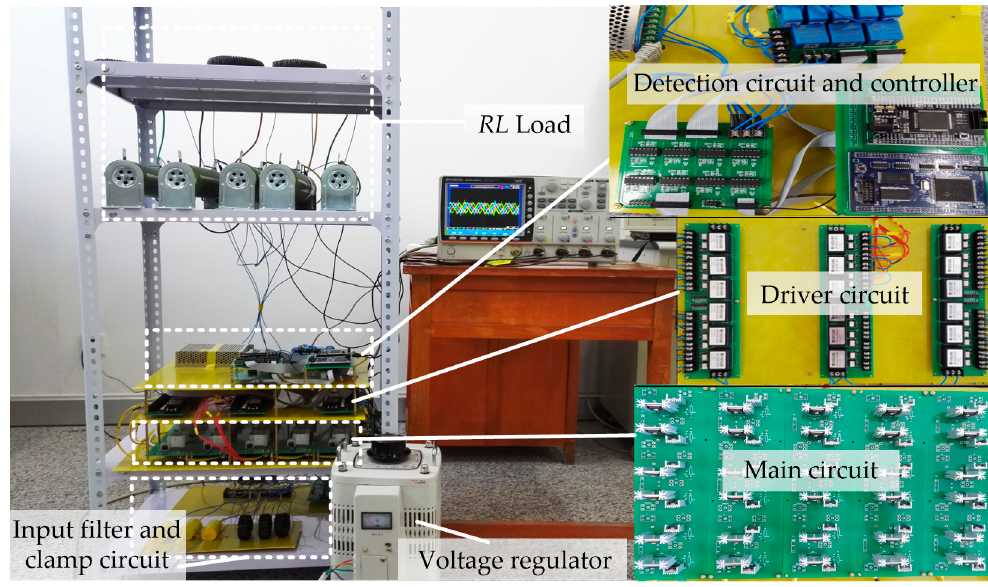
Figure 5. Experimental prototype.